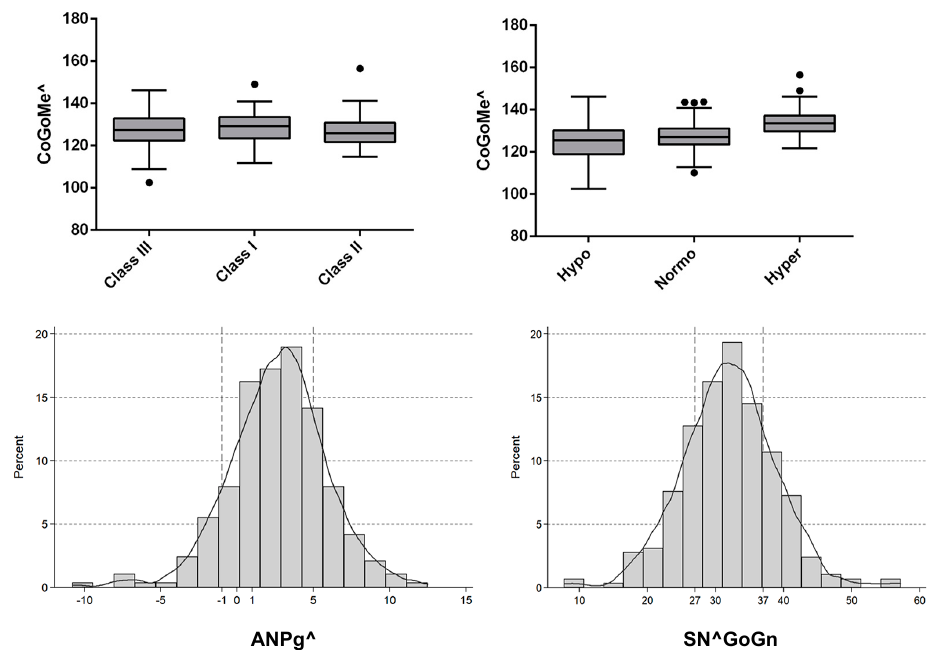
Figure 4. Box-and-whiskers plots (upper panel) of the CoGoMe angle by ANPg^ and SN^GoGn. Line in the box: median value. Box hinges: 25th–75th percentiles; ends of the segments: 5th–95th percentiles; and dots: outliers. Histograms with kernel distribution (lower panel) were presented to describe ANPg^ and SN^GoGn variables. Cut-off values were highlighted with dashed line ( − 1 and 5).